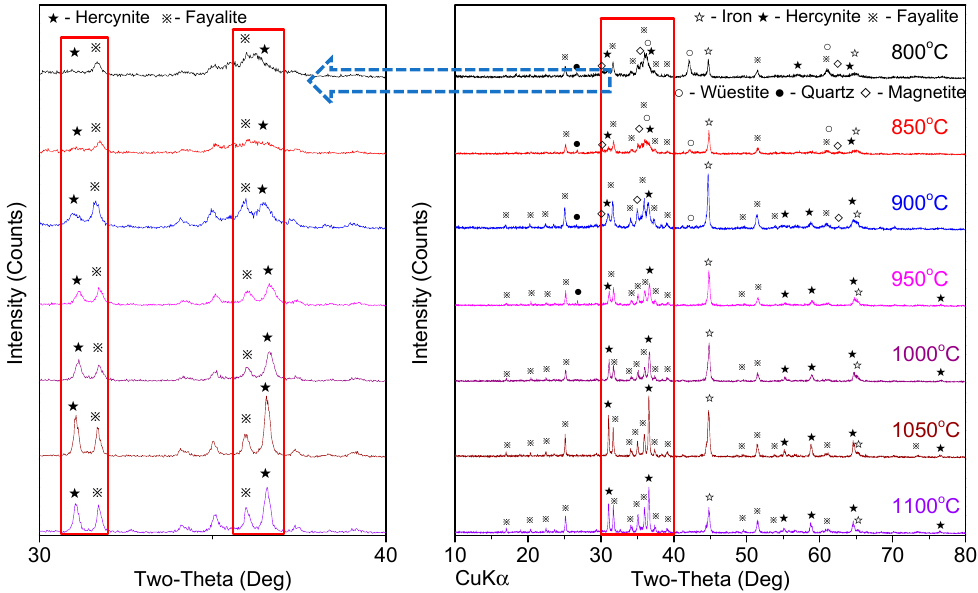
Figure 9. Effect of reduction temperature on mineral compositions of high-aluminum iron ore (HA) reduced pellets (reducing for 60 min with C/Fe mass ratio of 1.5).